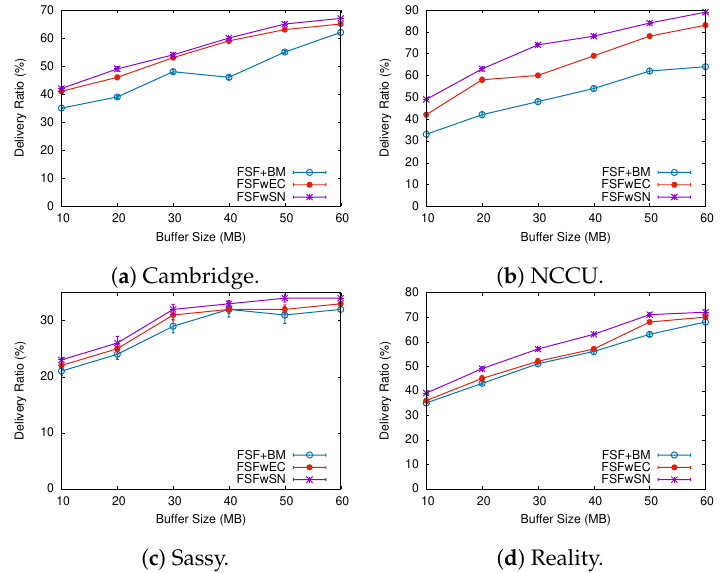
Figure 14. Delivery ratio when varying the buffer